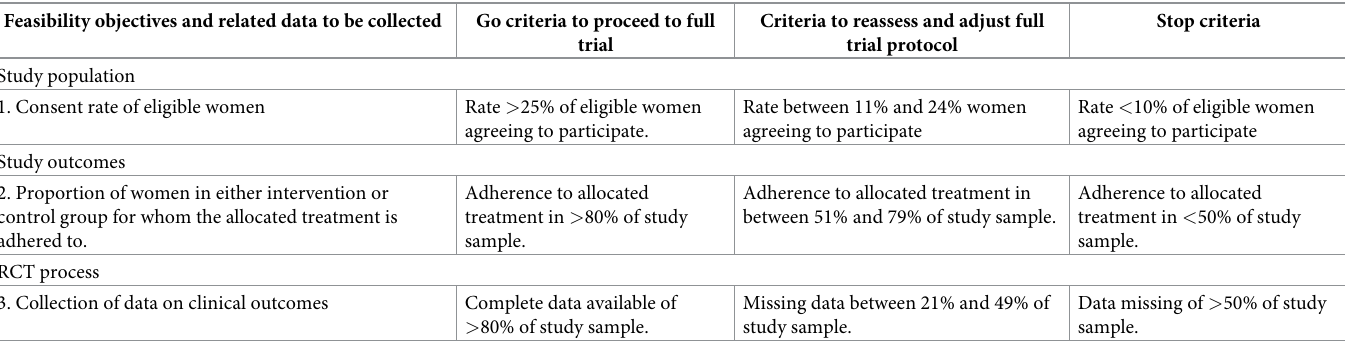
Table 1. Suggested progression criteria in eIPV